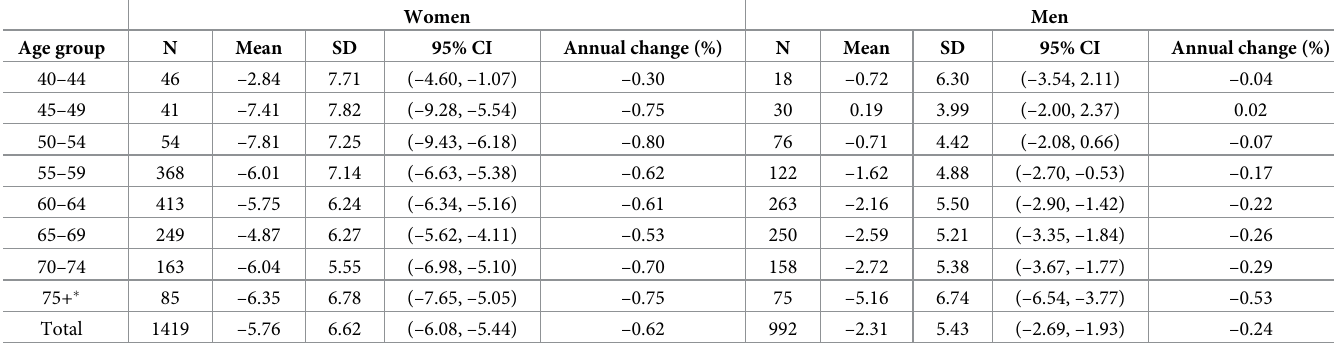
Table 3. Change per year in age-stratified left total hip bone mineral density (mg/cm 2 and percent) from Troms ø 5 to Troms ø